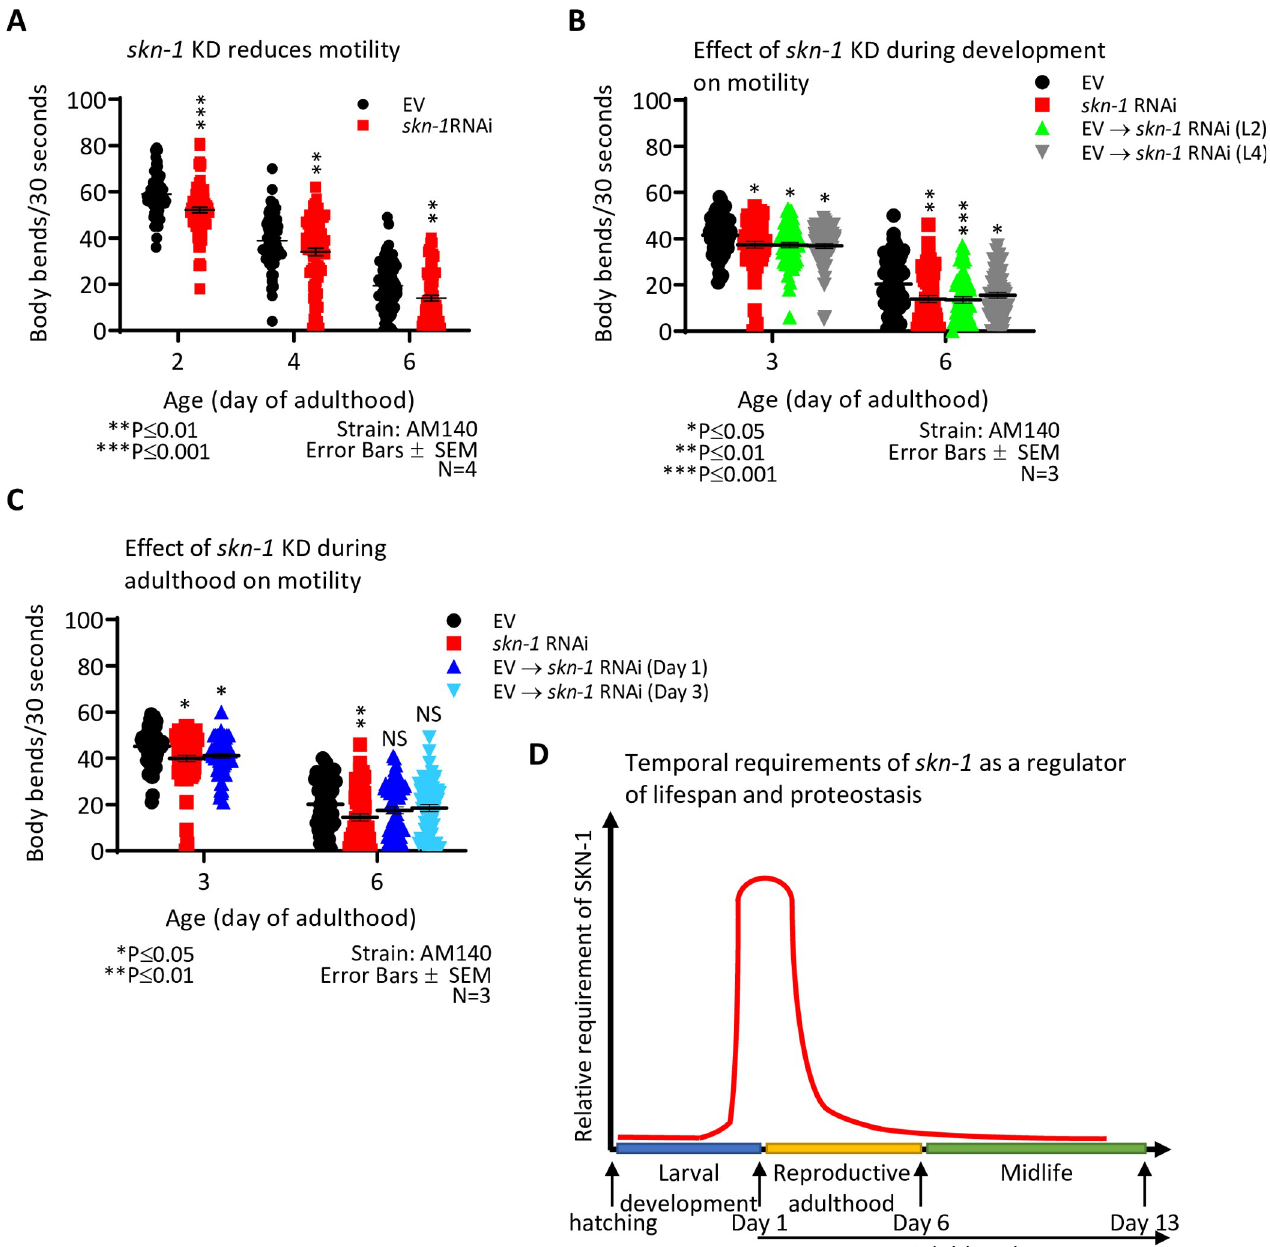
Fig 3. skn-1 expression is most critical from the late larval development through day 1 of adulthood to counter polyglutamine (polyQ) induced proteotoxicity. ( A ) The knockdown of skn-1 by RNAi significantly decreased the thrashing rates of worms that express polyQ35-YFP in their muscles (strain AM140) at day 2, 4 and 6 of adulthood (reduction of 11.64%, 12.29% and 27.60%, respectively). 80 worms were scored per treatment per timepoint. ( B ) Growing AM140 worms on control bacteria from hatching followed by transferring them onto skn-1 RNAi at the L2 or L4 developmental stage resulted in enhanced proteotoxicity as measured by the thrashing assay (Reduction of 10.45% and 11.29% at day 3, respectively, and a reduction of 33.64% and 23.6% at day 6, respectively). 60 worms were scored per treatment per time point. ( C ) The knockdown of skn-1 from day 1 (reduction of 10.38% and 7.35% when measured at day 3 and day 6, respectively) resulted in a significant trend of reduced motility only when measured on day 3 of adulthood. The transfer of EV treated worms to skn-1 RNAi on day 3 of adulthood, resulted in a non-significant trend of reduced motility when measured on day 6 of adulthood (reduction of 10%). 60 worms were scored per treatment per time point. ( D ) A schematic illustration of the temporal requirements for SKN-1 as a regulator of lifespan and proteostasis.